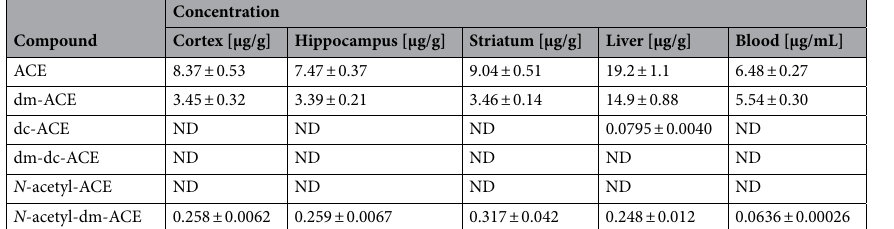
Table 4. The concentration of ACE and dm-ACE in organs and blood in an acute exposure experiment (Data are expressed as mean ± SEM). Abbreviations: ACE acetamiprid, dm-ACE Acetamiprid- N -desmethyl, dc-ACE N -descyano-acetamiprid, ND not